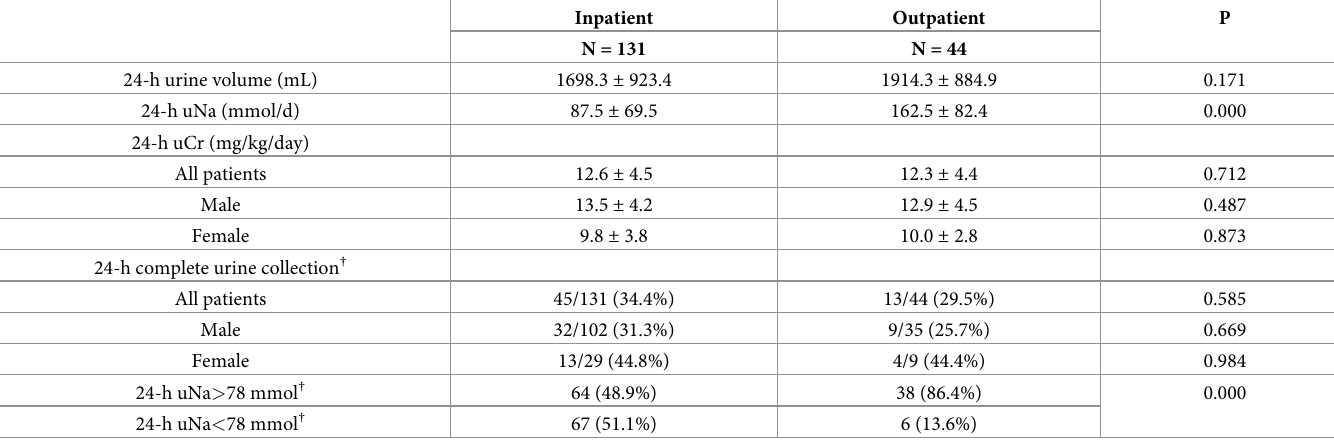
Values in table are presented as the mean ± standard deviation. The proportions are presented as percentages for categorical